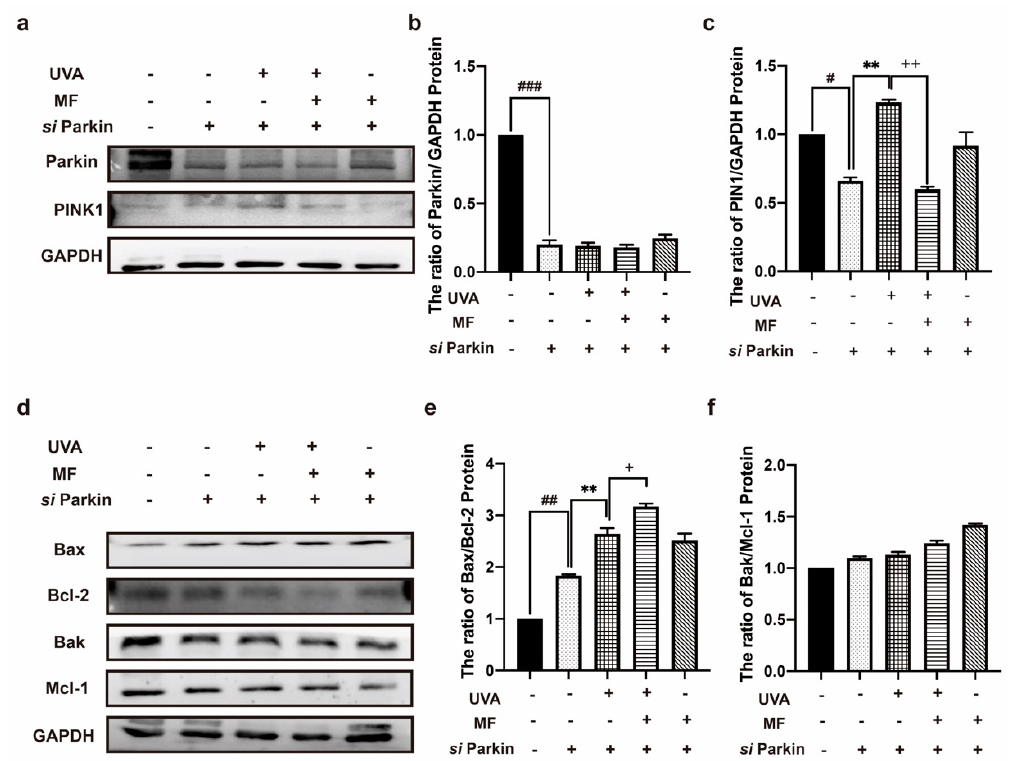
Figure 6. Alteration of Parkin expression can regulate apoptosis in HFF cells after UVA irradiation. ( a – c ) Levels of mitophagy proteins Parkin, PINK1, measured by western blot in response to Parkin knockdown. ( d – f ) Levels of apoptosis-related proteins Bax/Bcl − 2 and Bak/Mcl − 1 measured by western blot in response to Parkin knockdown. Data are presented as mean ± SD, n = 3. # p < 0.05, ## p <0.01, ### p < 0.001 vs. control cells, ** p < 0.01 vs. UVA ‐ treated cells, + p < 0.05, ++ p < 0.01, vs. metfor ‐ min co ‐ treated cells.